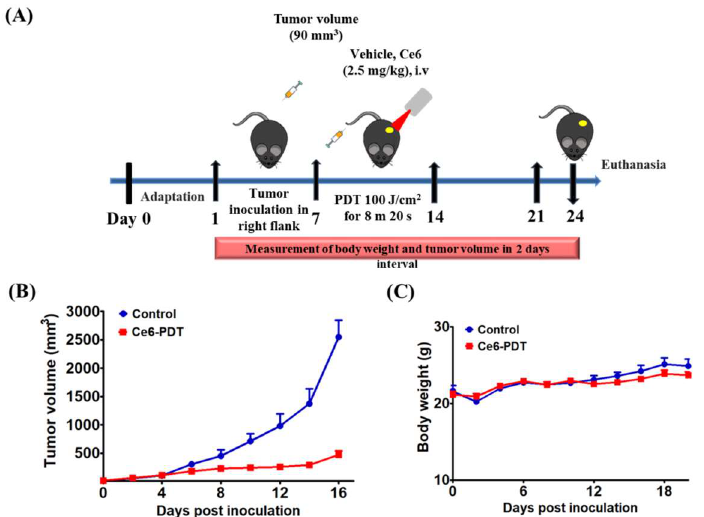
Figure 4. Inhibitory effect of Ce6 PDT on tumor growth in mice with transplanted B16F10 cells. The mice were subcutaneously injected in the right flanks with 0.1 mL of B16F10 cells (1 × 10 5 cells/mL). The control group was not exposed to any treatment, while Ce6 (2.5 mg/kg) followed by irradiation was given to the treatment groups. ( A ) Scheme showing the protocol of allograft model. ( B ) The values of tumor volume in vehicle-treated control and treatment groups, and ( C ) body weight changes. Data are expressed as mean ± SEM, n =